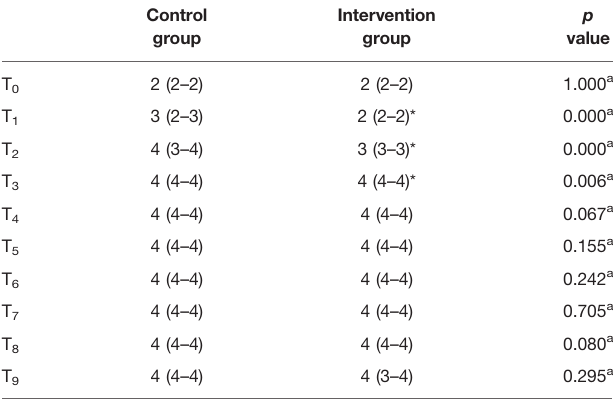
TABLE 3 | Ramsay sedation